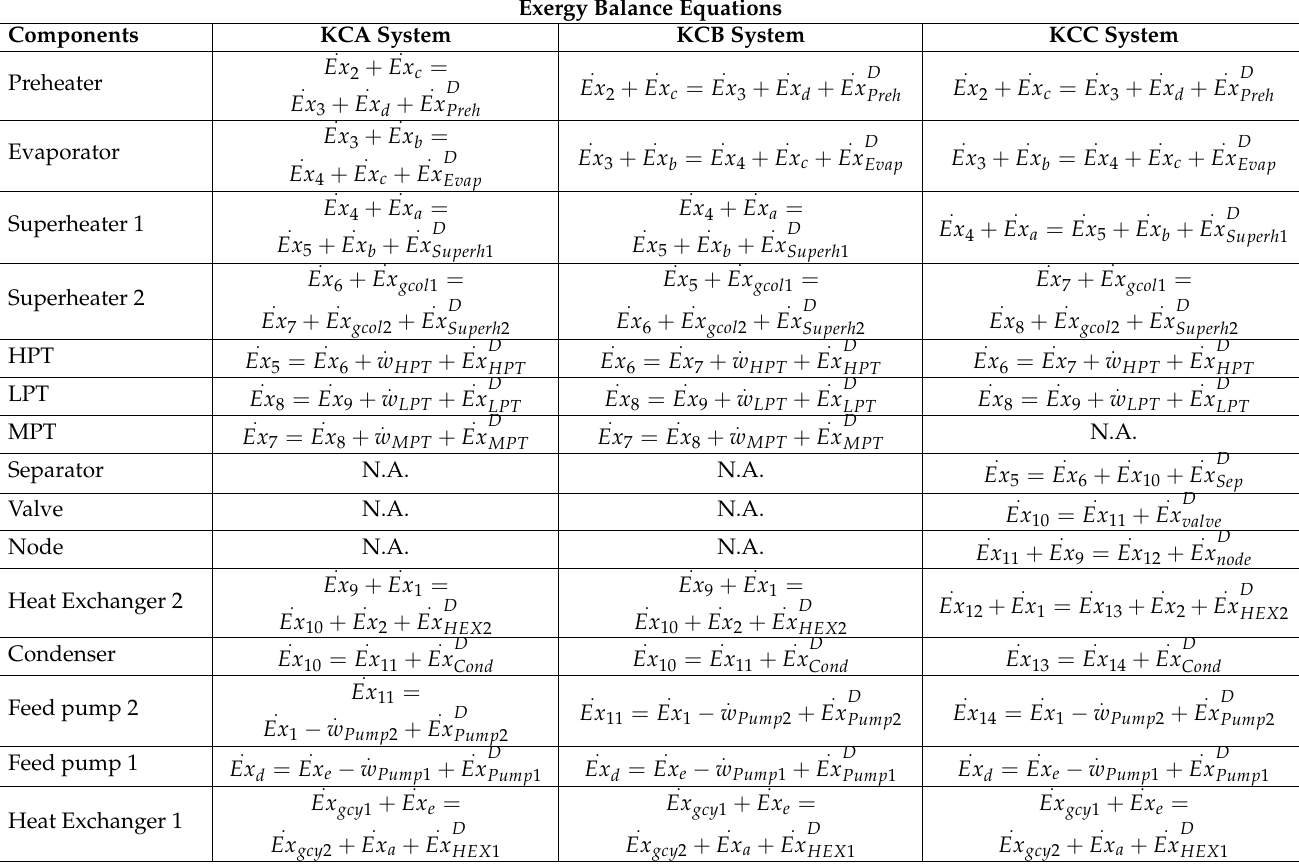
Table 5. Exergy degradation balances for the system